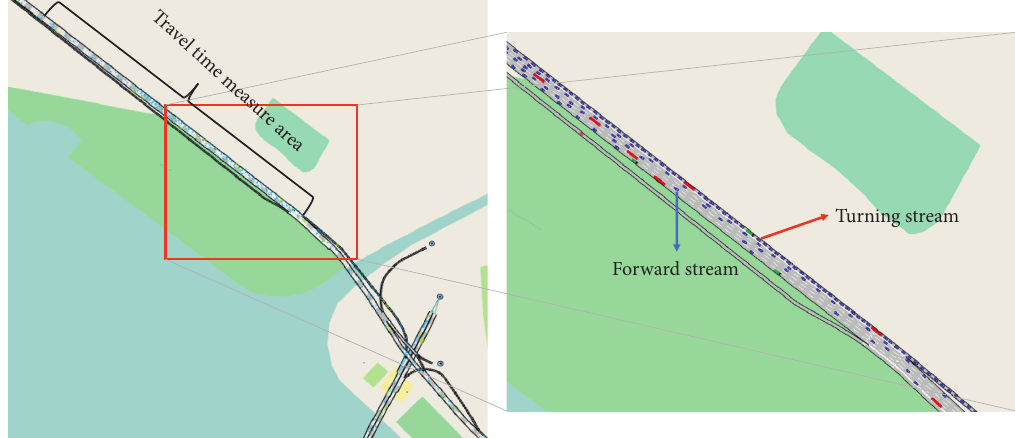
Figure 1: Example of diverge bottleneck on highways.